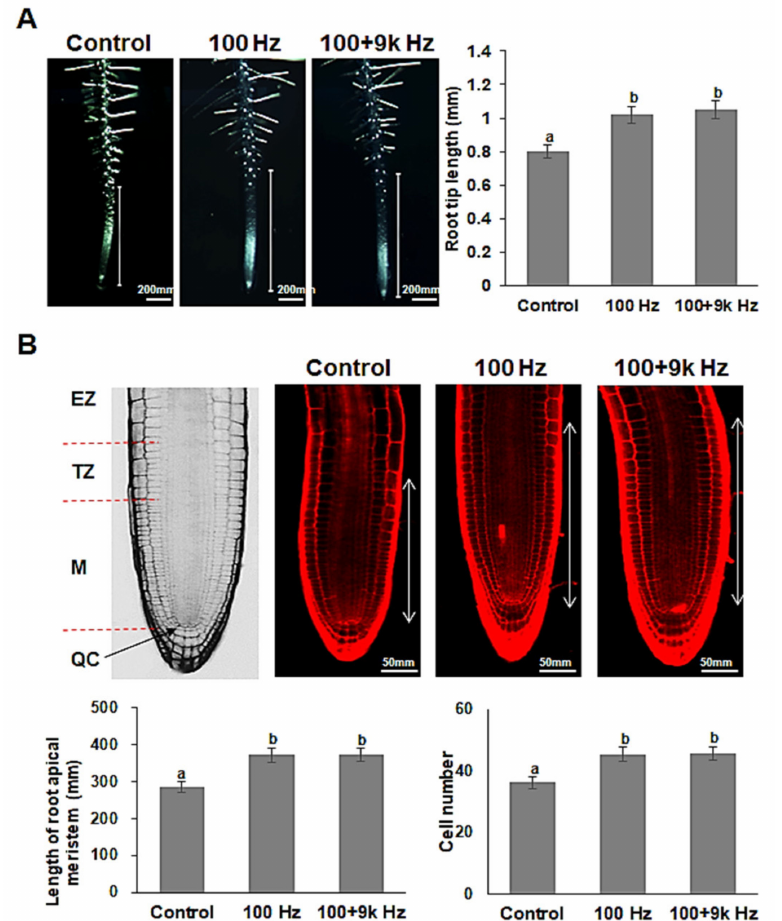
Figure 2. Effect of sound wave treatments on root tip growth and length and cell number of root apical meristem in Arabidopsis thaliana . ( A ) Measurement of root tip length by optical microscopy ( × 60) at the 5th day after sowing of wild type (Col-0) seed treated with or without sound waves. ( B ) Observation of the root apical meristem (M + TZ) and measurement of the length and cell number in this region by confocal microscopy. QC; Quiescent center, M; Meristem, TZ; Transition zone, EZ; Elongation zone. Values represent the means of three measurements ( ± standard error). Different letters above the bars indicate significantly different mean values ( p < 0.05) based on Duncan’s multiple range test. Scale bars represent ( A ) 200 µ m and ( B ) 50 µ m. This experiment was conducted at least three times, and each experiment measured 15–20